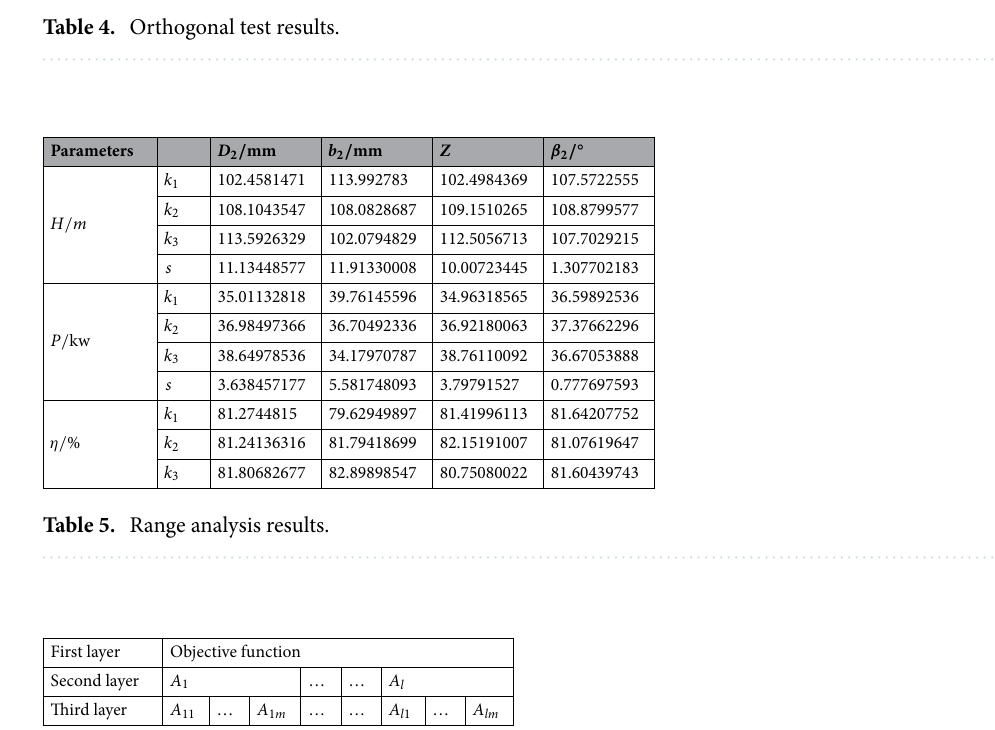
Table 6. Data structure of weight matrix